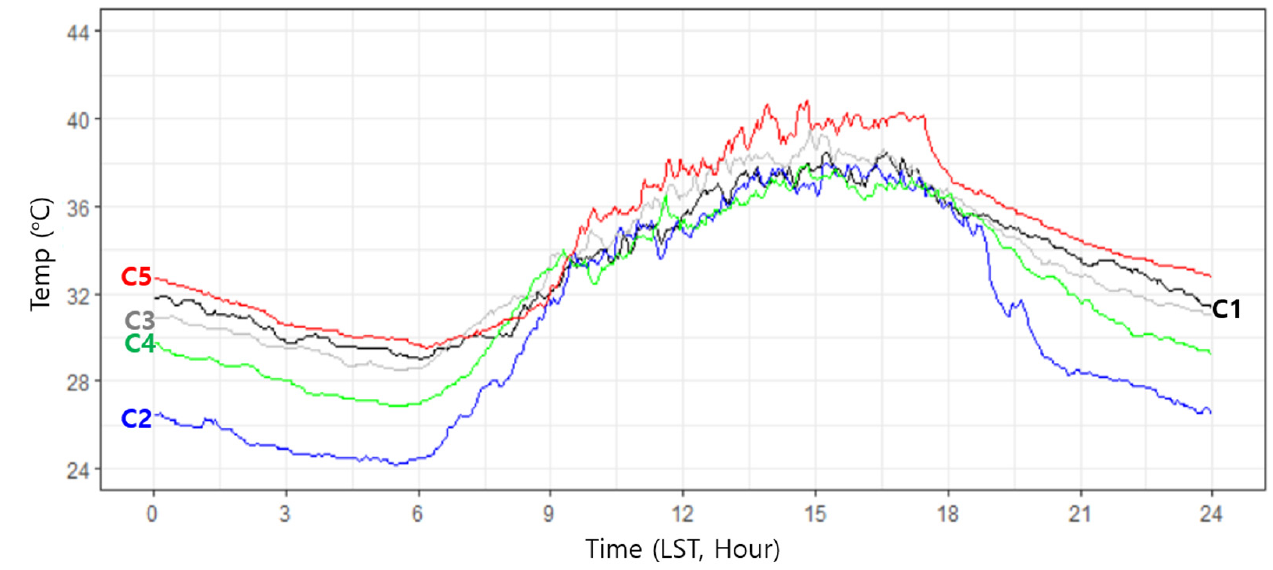
Figure 4. Location of ( a ) all stations and ( b ) Cluster 1, ( c ) Cluster 2, ( d ) Cluster 3, ( e ) Cluster 4, and ( f ) Cluster 5 stations.